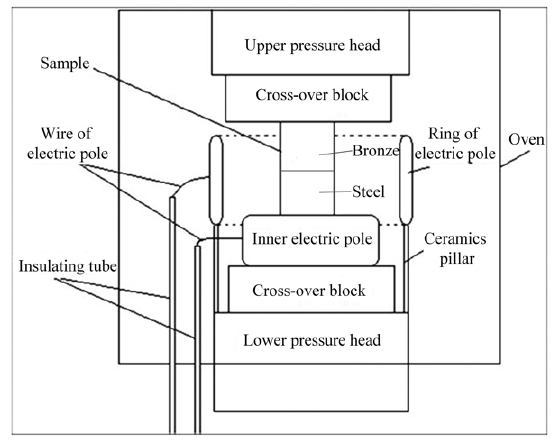
Figure 1. Schematic showing the setup of electro-superplastic solid state welding.